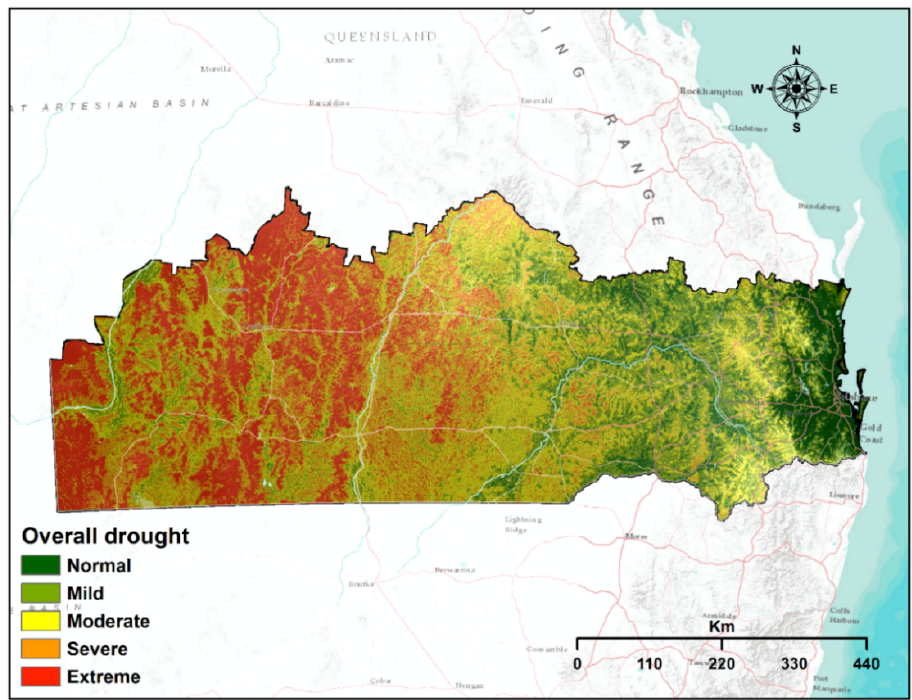
Figure 7. Overall vulnerability map indicating the spatial footprint and vulnerability to overall drought.